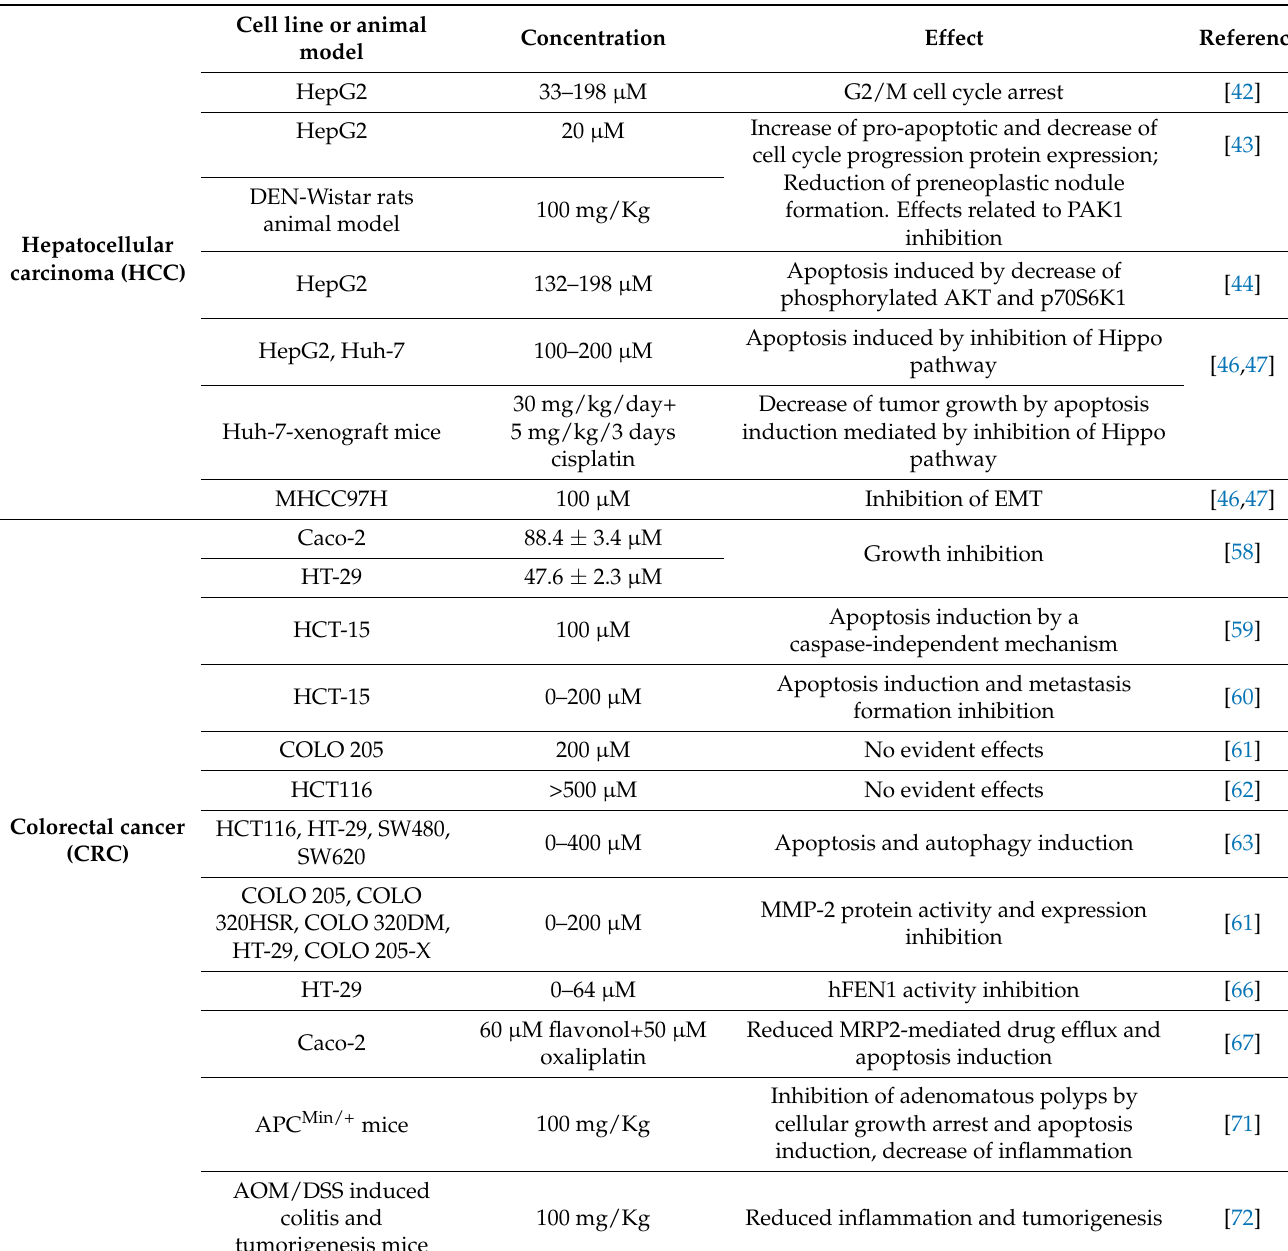
Table 1. Anti-cancer effects of myricetin in different in vitro and in vivo experimental